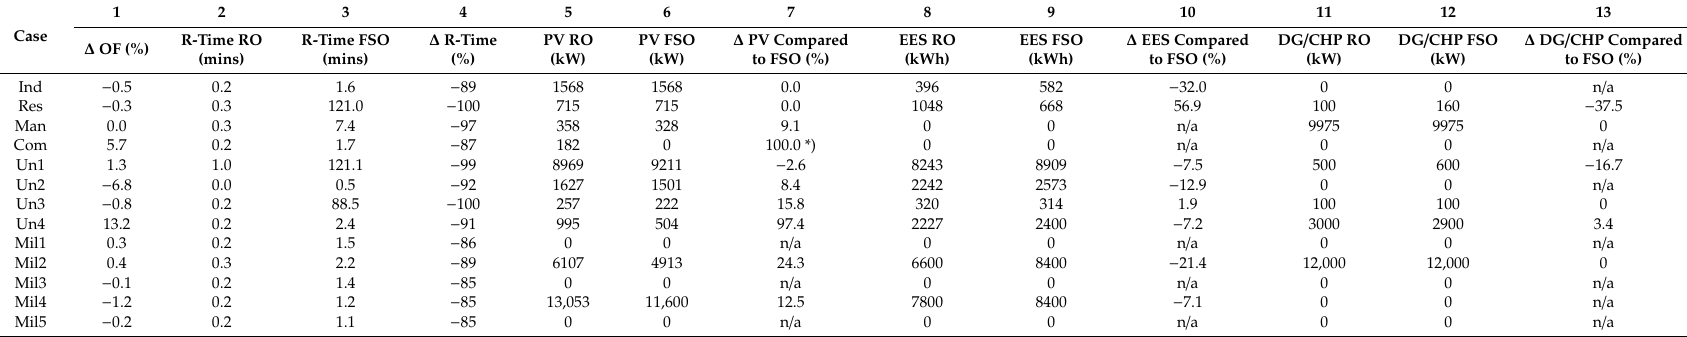
Table 2. Overview results for the 13 modeled Microgrids. OF: Objective Function; R-time: Run-time; RO: Down-sampled representative day-types optimization.